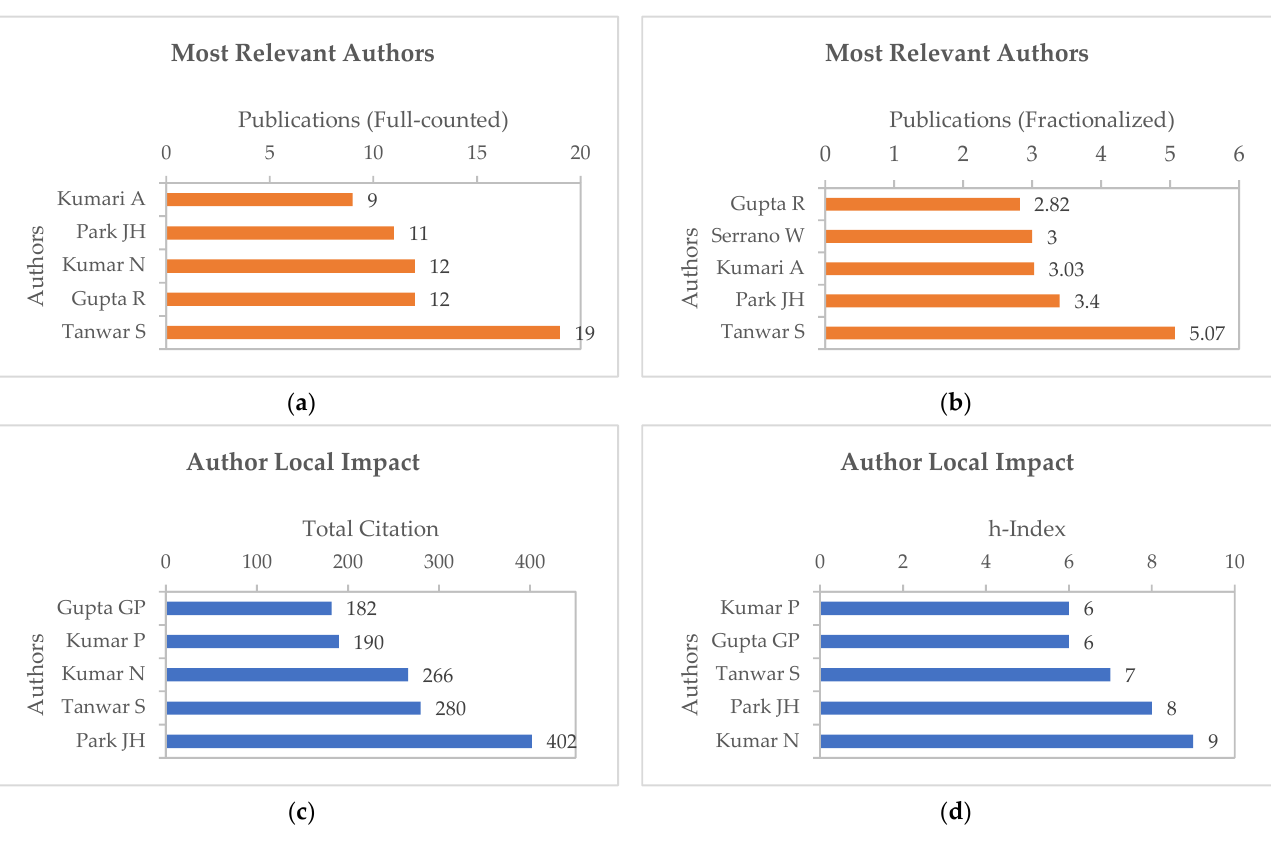
Figure 3. Authors’ productivity in terms of number of documents: ( a ) full-counted; ( b ) fractionalized; ( c ) total citations; ( d ) h-index.